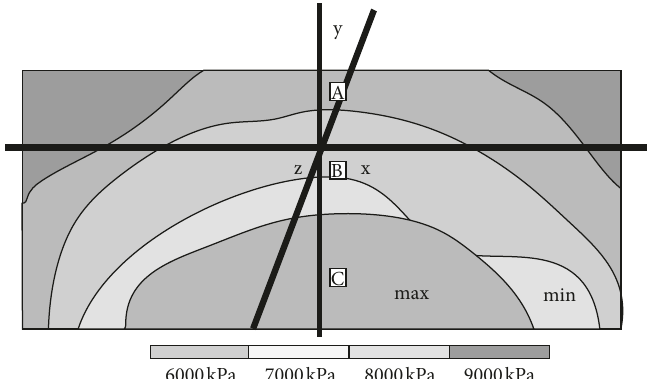
Figure 3: Stress nephogram of points a, B, and C in ( x , y , z ) direction.